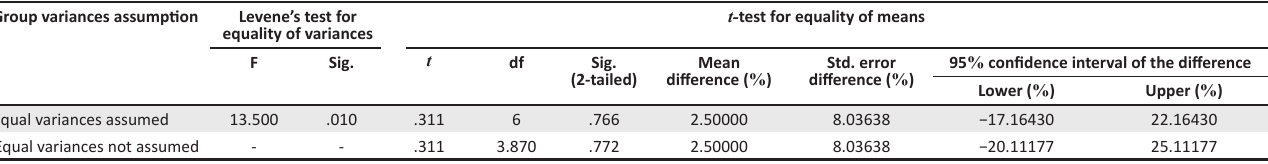
TABLE 3: Independent samples t -test for Pre-test Two between the experimental and control groups. Group variances assumption